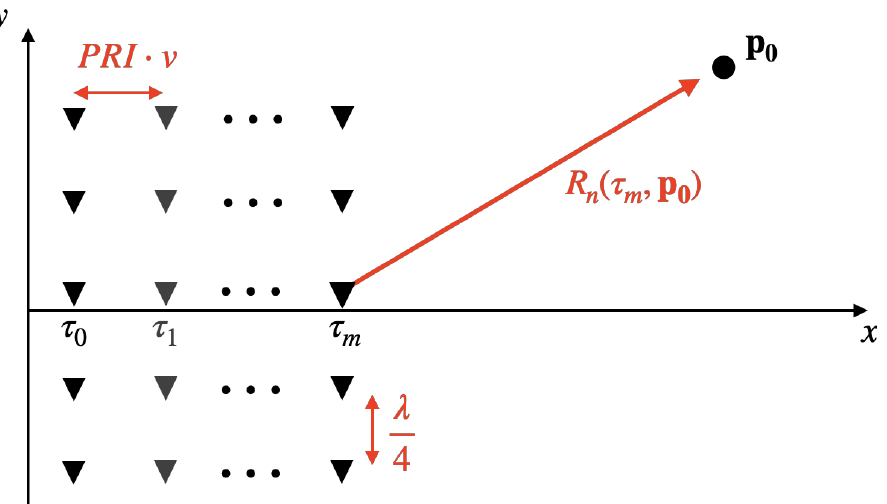
Figure 2. Uniform Linear array with spacing distance d = λ /4 in forward SAR looking configuration, with a reference point target p 0 moving at a speed v with a Pulse Repetition Interval PRI